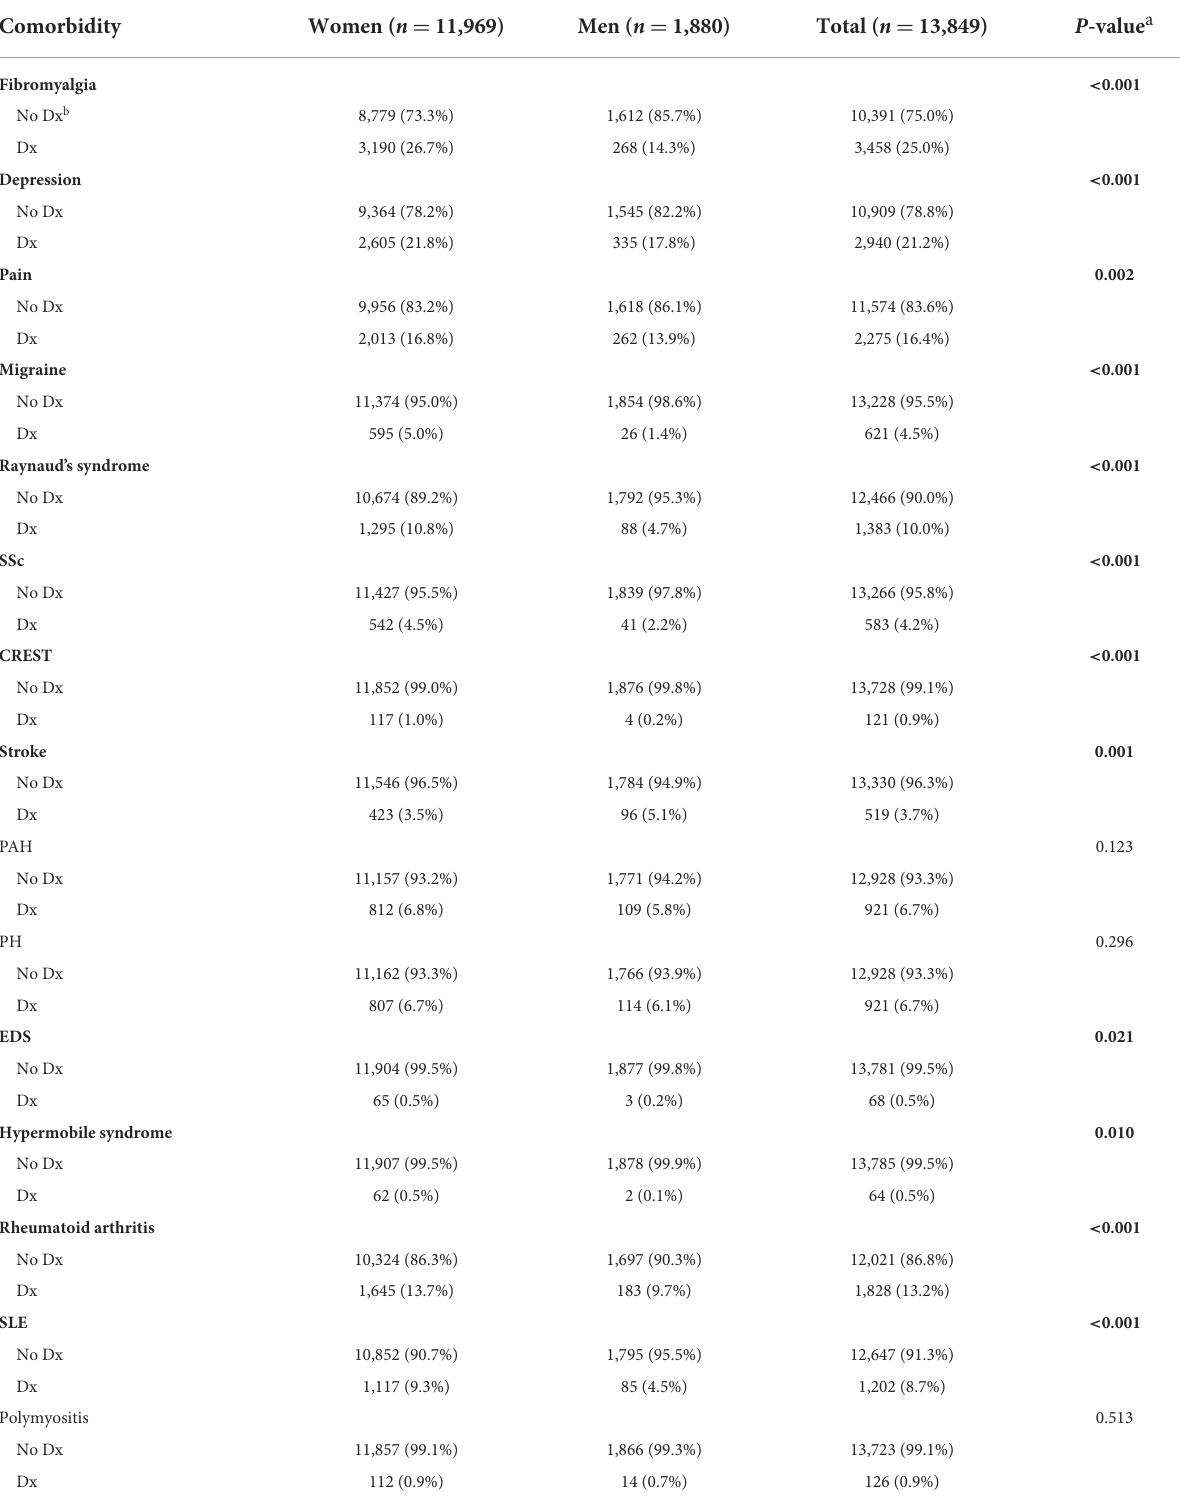
TABLE 10 Comorbidities in women and men with Sjögren’s disease by sex ( n = 13,849). Comorbidity Women ( n = 11,969) Men ( n = 1,880) Total ( n = 13,849) P -value a